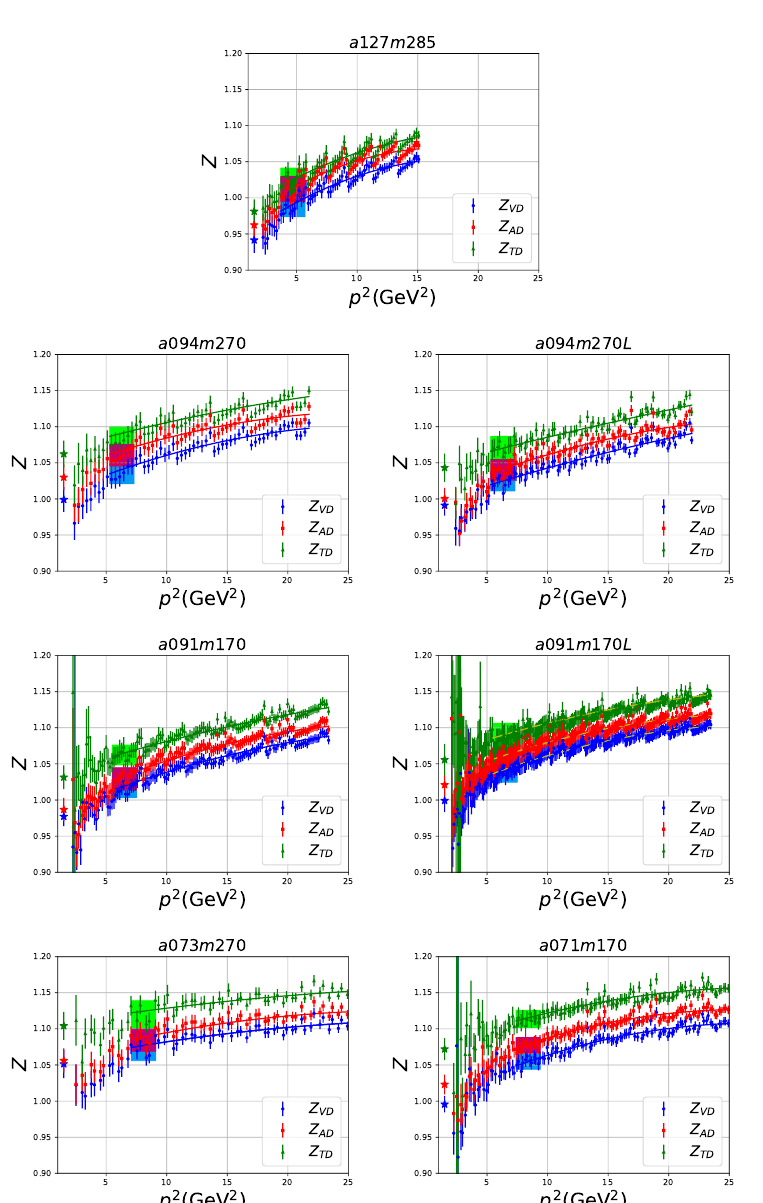
Figure 11 . Nonperturbative renormalization factors for h x i u − d , ( Z V D ), h x i ∆ u − ∆ d , ( Z AD ), and h x i δu − δd , ( Z TD ) in the MS scheme at µ = 2 GeV for the seven ensembles. In all cases, the extent along the x-axis of shaded bands marks the region in p 2 that is averaged in Method A and the height is twice the error in the estimate. The points next to the y-axis with the star symbol give a second estimate (Method B) obtained from a fit with ansatz Z ( p ) = Z at the left edge of the